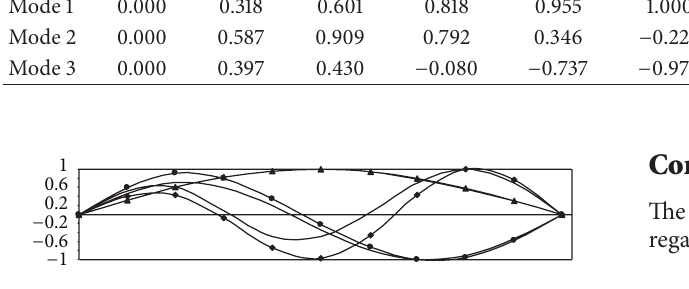
Figure 6: Optimal and target mode shapes (Case